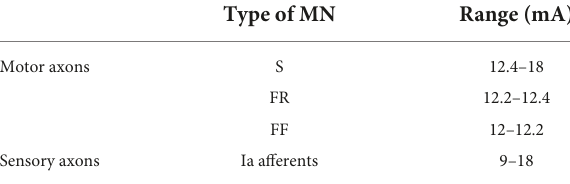
TABLE 2 Range of thresholds to electrical stimulation for motor and sensory axons represented in the computational model of the neuromuscular system.